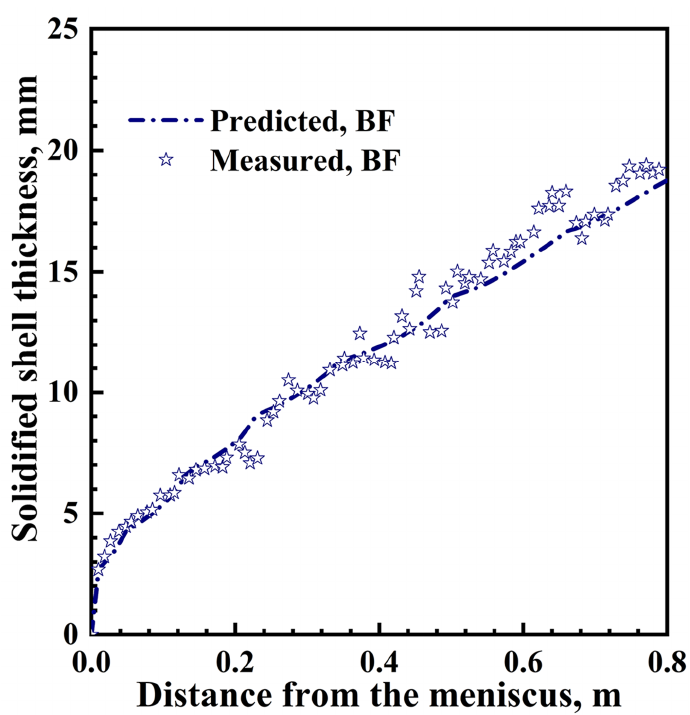
Figure 2. The variation of solidified shell thickness in mold along the casting direction.